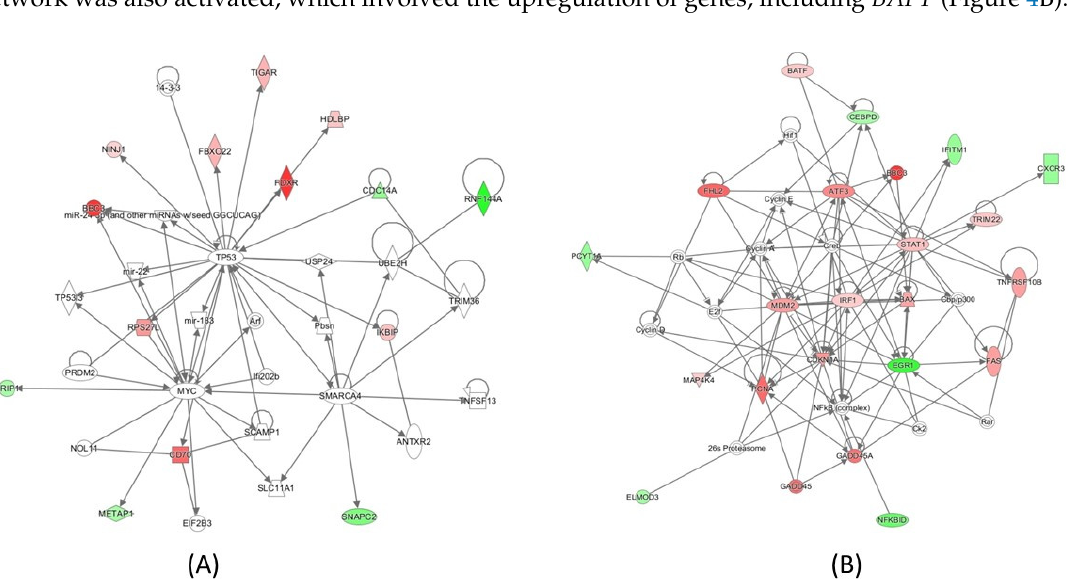
Figure 3. Fold changes of gene expression in selected genes after radiation exposure in the 3 clusters of CD4 + , CD8 +/ NK, and naïve cells. FDXR and BBC3 were upregulated by radiation, whereas HSPA1A was downregulated, in all three groups. The upregulation of STAT1 and IRF1 was found in CD4 + and naïve cells, but not in CD8 +/ NK cells. Bars represent the standard error of the mean. Table 3. Genes whose expressions were downregulated signicantly when all of the cells or cells in individual cell types were considered. The genes meet the criteria of Fold Change (FC) > 2 (log 2 FC < − 1) and p < 0.001.